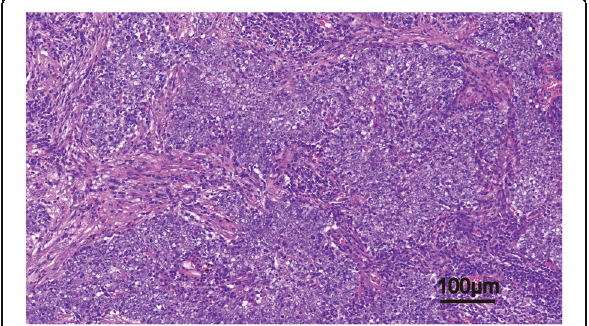
Fig. 1 LELC grew infiltrative in the fibrous interstitium and arranged in sheets and syncytial pattern. Neoplastic cells presented vacuolar nucleus with prominent nucleoli and a marked lymphocytic infiltrate. (H&E stain, 200 × magnification)